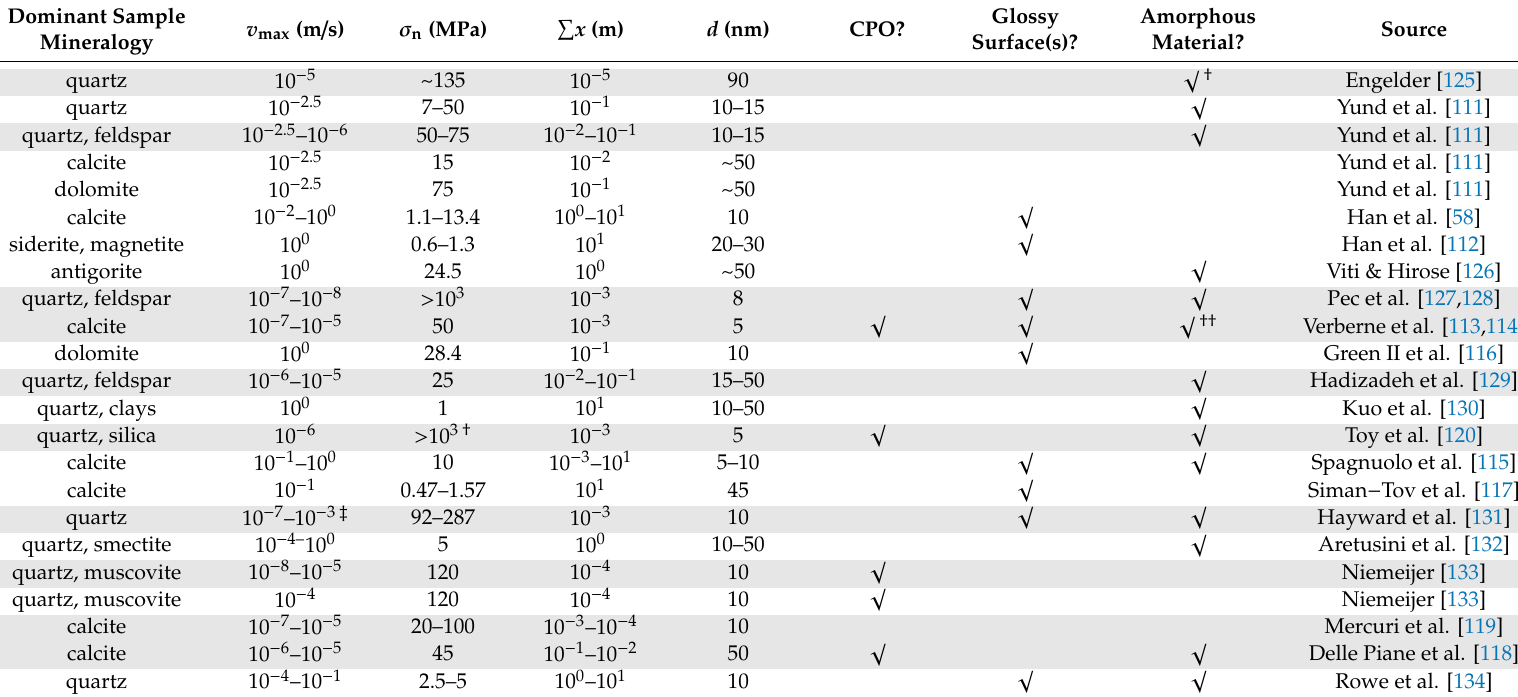
Table 2. List of reports, in chronological order, of < 100 nm-sized grains in experimentally-formed principal slip